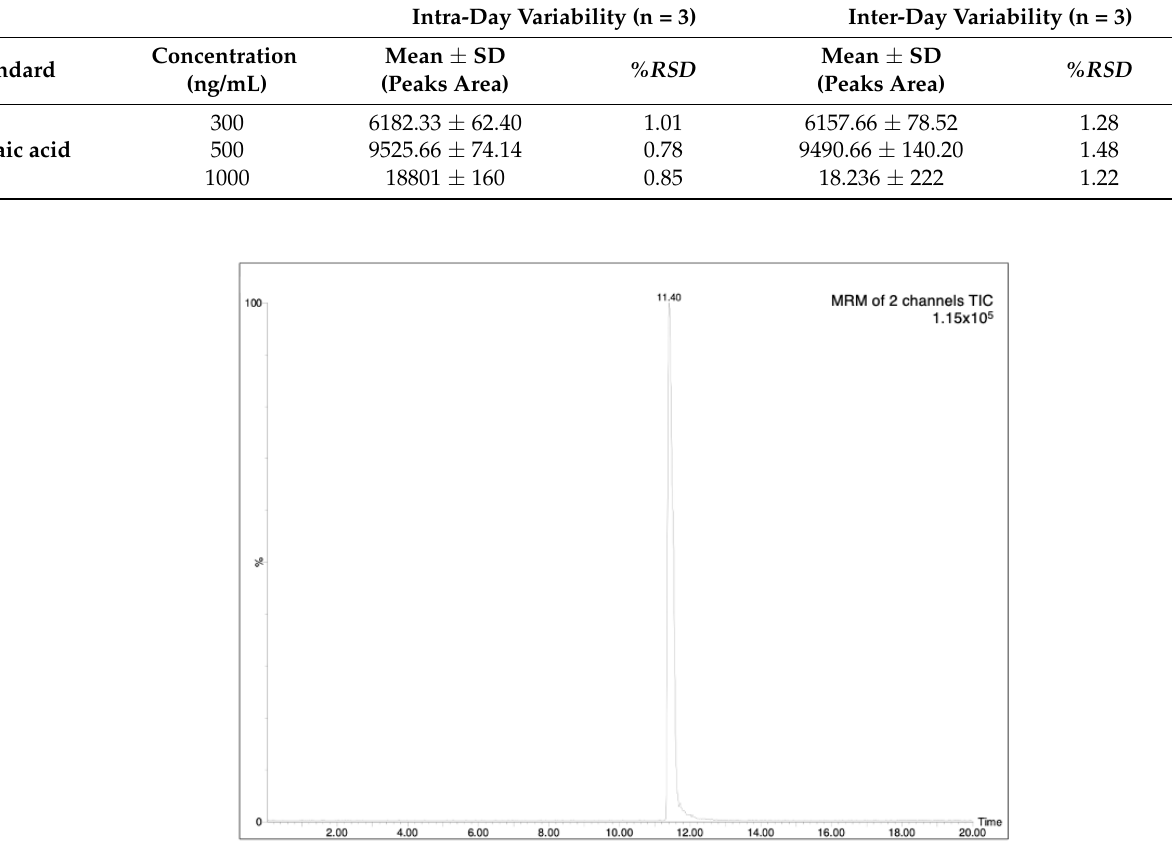
Table 2. Intra-day and inter-day variability of Aza.